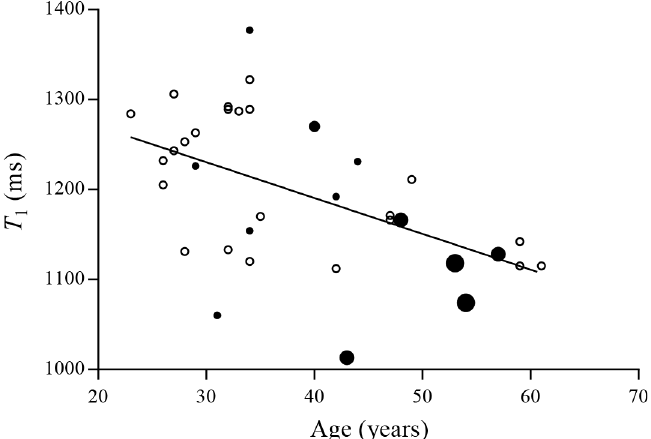
Fig 2. Lung T 1 as a function of age and PY for all subjects. The example line shows the correlation between median lung T 1 and age for smokers ( ● ) and never smokers ( (cid:1) ), indicating that lung T 1 shortens with ageing (p < 0.01, r = -0.52). The smoking history of the current smokers is visualized with increased size of the (cid:3) (cid:3) = 21 – 30 PY and = 31 – 40 PY). dots ( (cid:3) = 1 – 10 PY, (cid:3) = 11 – 20 PY,